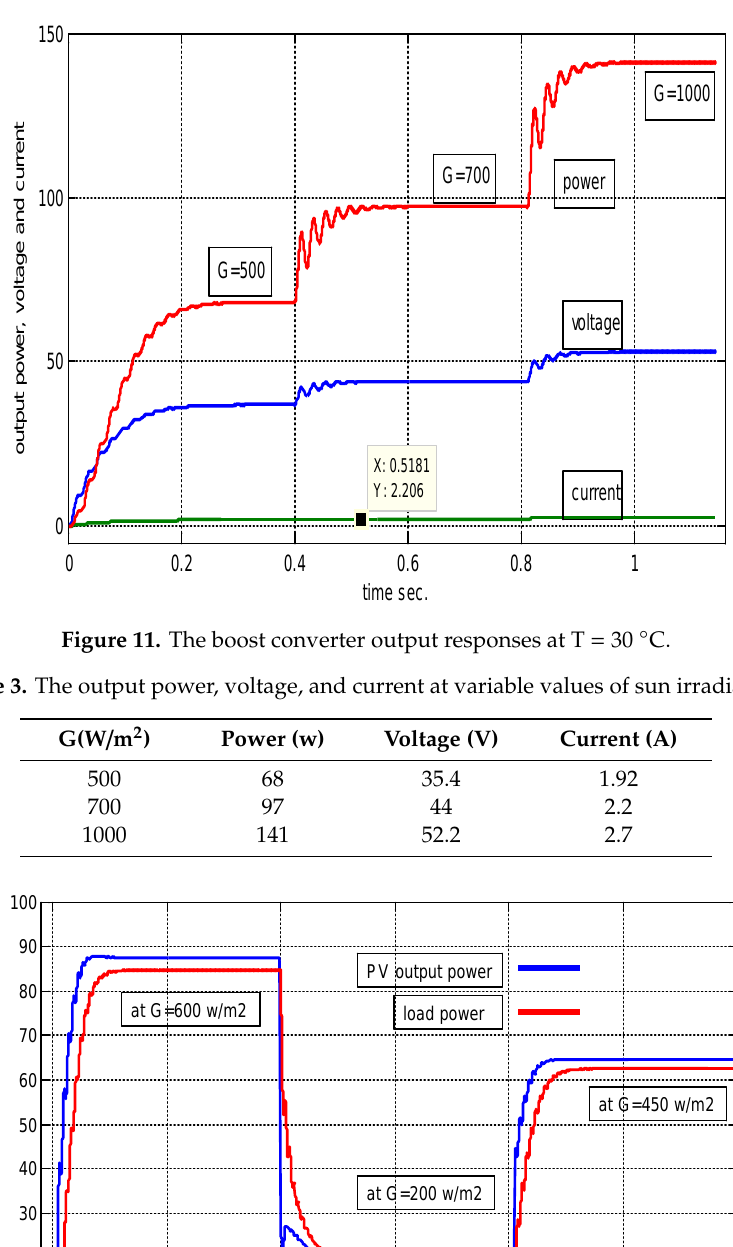
Figure 12. Load power tracking to the PV output power at T = 30 °C.